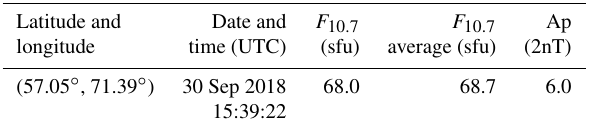
Table 3. The input parameters of NRLMSISE-00 for the calculation of the model atmospheric density